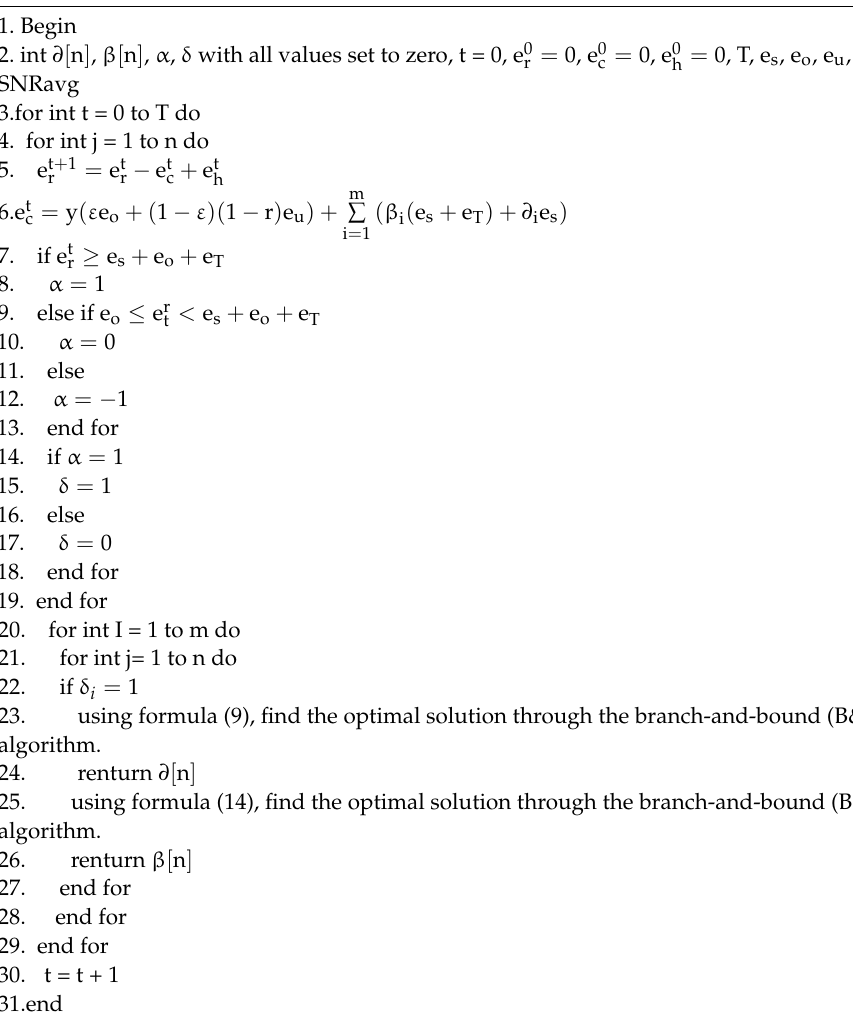
Algorithm 1 Based on Energy-Distributed User Selection